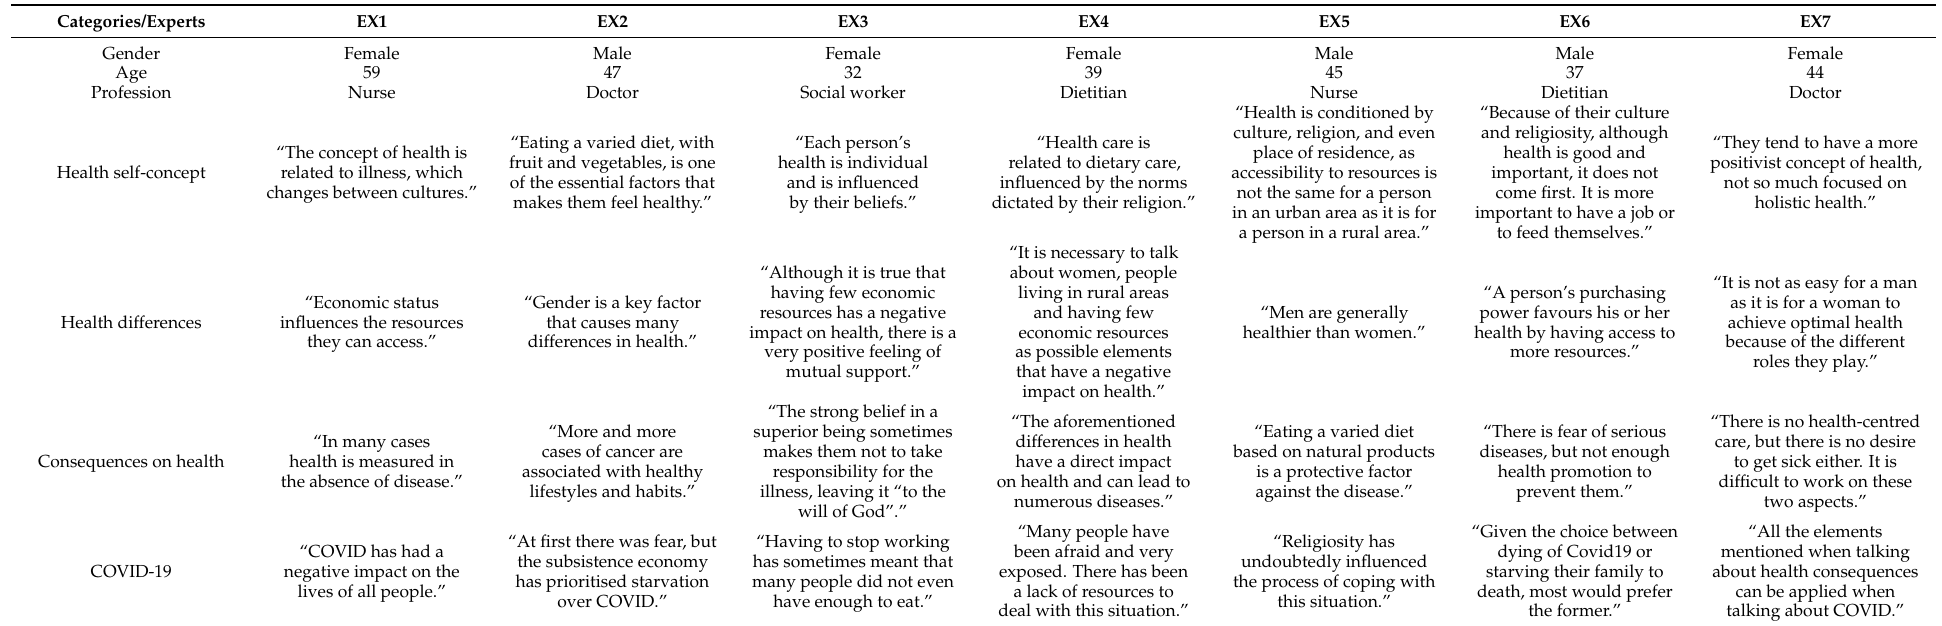
Table 1. Characteristics addressed in the expert